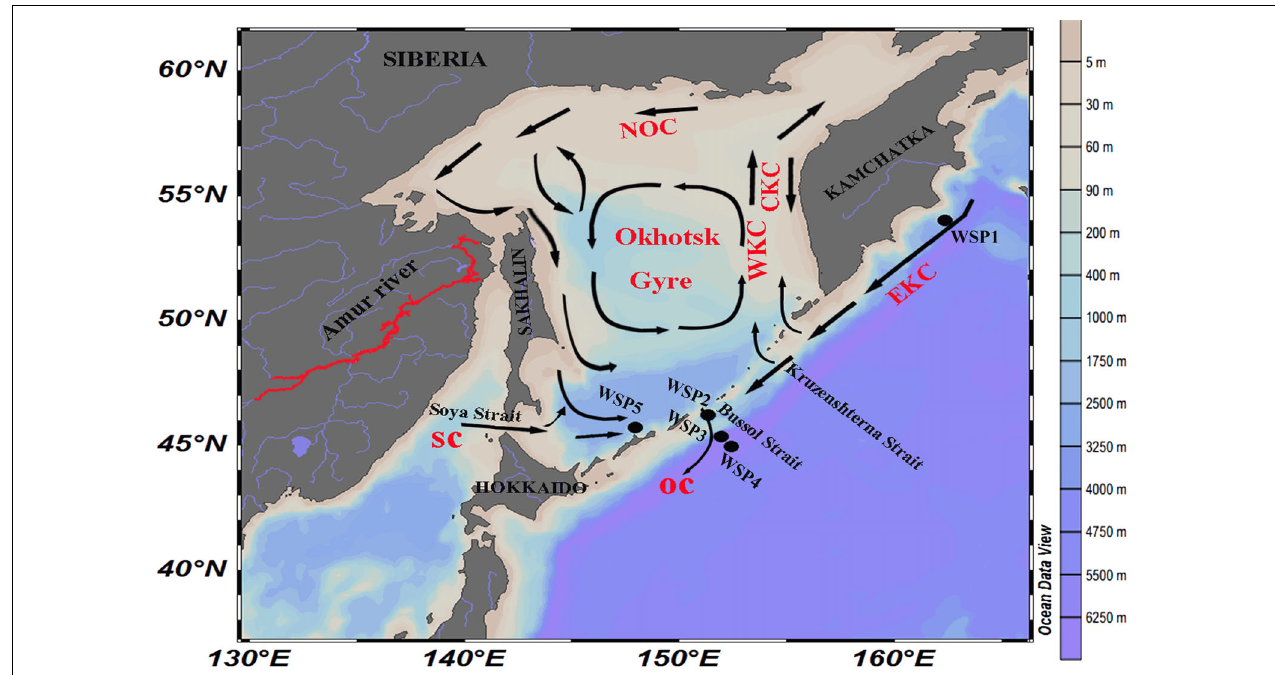
FIGURE 1 | Location of the sampling stations around the Sea of Okhotsk and North Western Subarctic Pacific Ocean. NOC, North Okhotsk Current; WKC, West Kamchatka Current; EKC, East Kamchatka Current; CKC, Compensation Kamchatka Current; SC, Soya Current; and OC, Oyashio